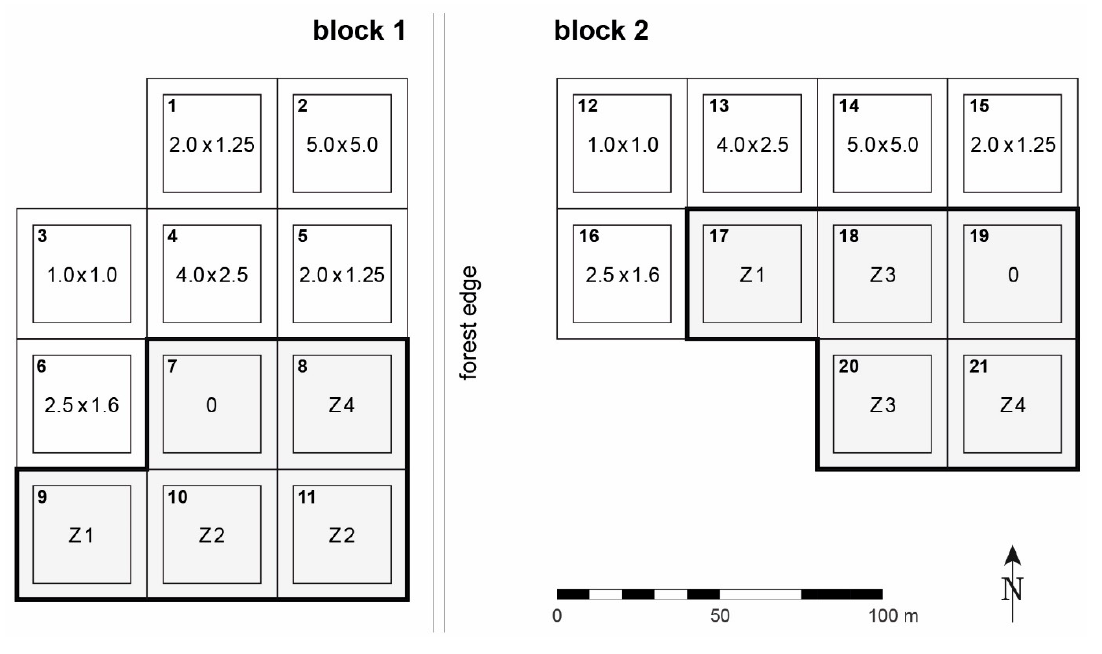
Figure 2. Study design of Fürstenfeldbruck 612 (FFB 612). The trial includes ten different spacing– thinning combinations in two blocks, comprising 21 equally sized, rectangular plots, each bordered by a buffer zone. Plots that are surrounded by thin lines differ regarding their initial spacing (spacing trial; 1.0 m × 1.0 m, 1.25 m × 2.0 m, 1.6 m × 2.5 m, 2.5 m × 4.0 m, 5.0 m × 5.0 m), whereas bold framed plots vary only in their thinning regime (thinning trial), having an initial spacing of 1.6 m × 2.5 m. The buffer zone was consistently treated similarly to the neighboring plots.